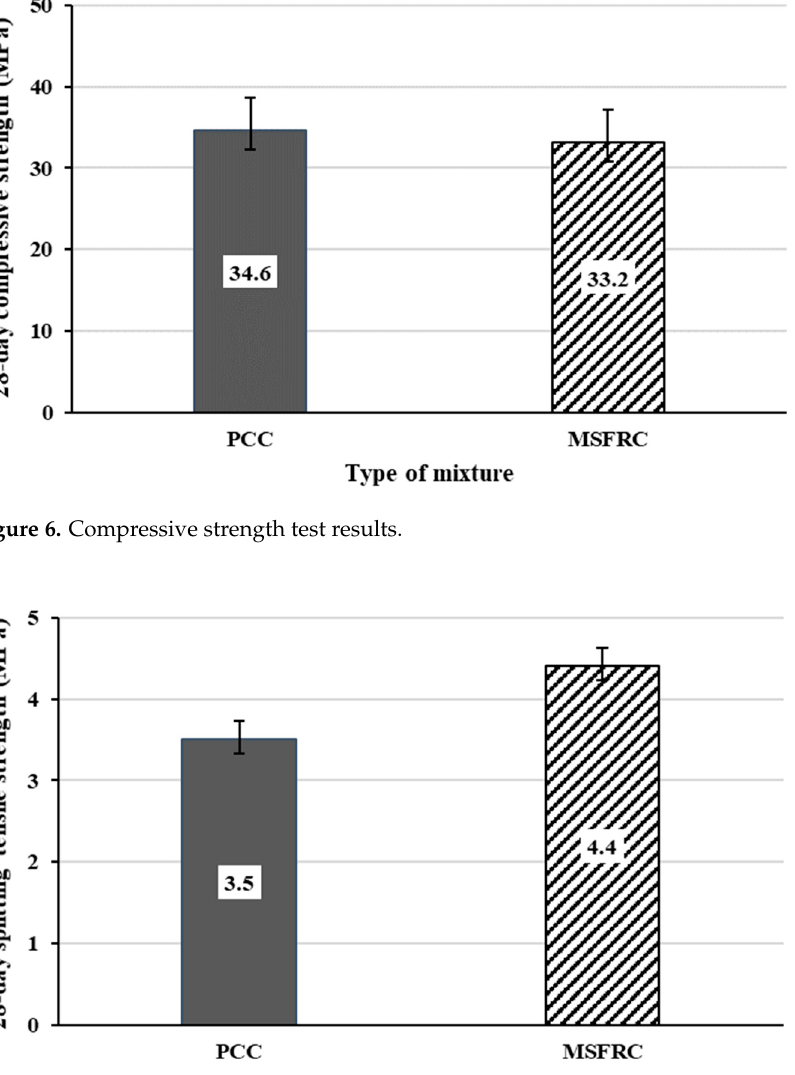
Figure 6. Compressive strength test results.